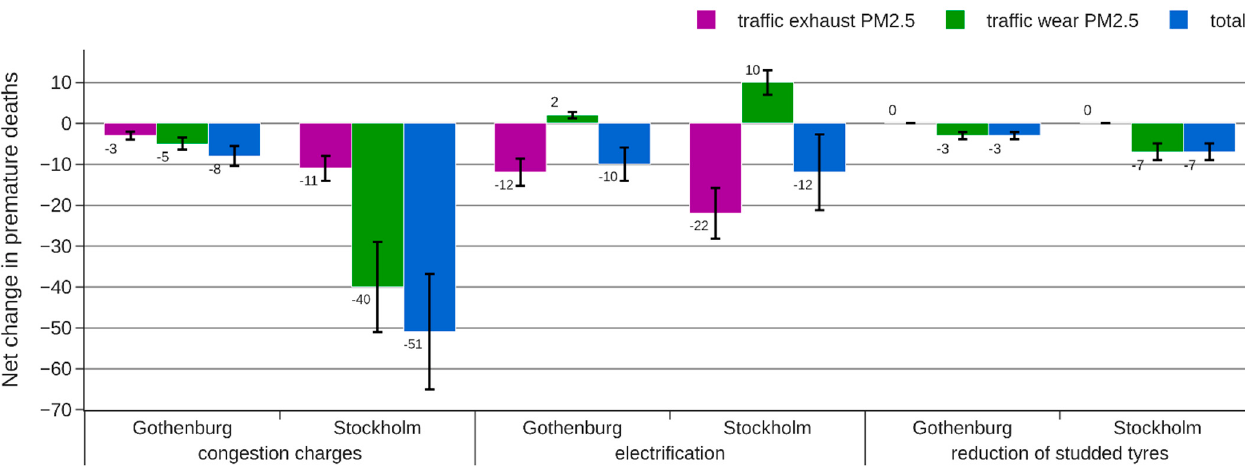
Figure 7. Estimated change in number of premature deaths for each of the abatement strategies following approach B (separation by distance to source). The error bars represent a 95% CI.